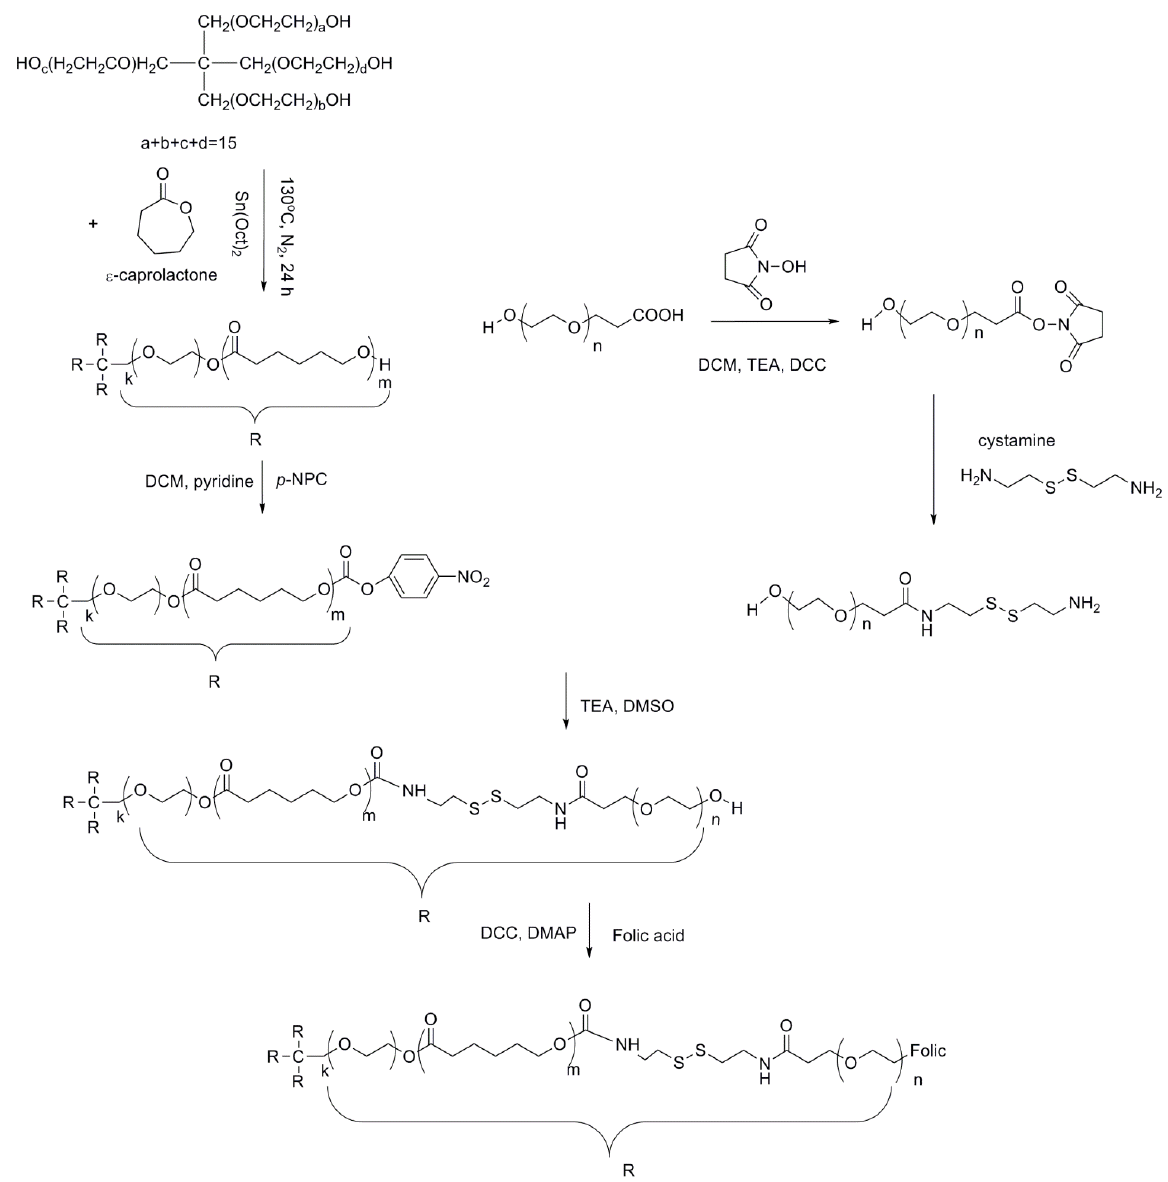
Figure 1. Synthetic scheme of 4SPCL-PEG-FOL copolymer.